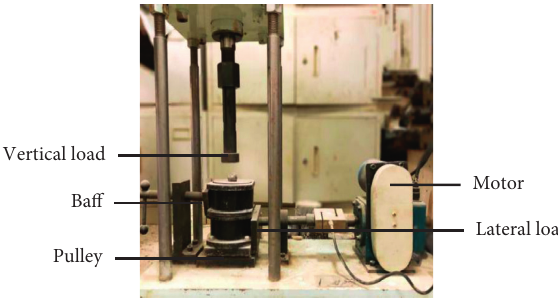
Figure 2: Pavement interlayer material shear tester.